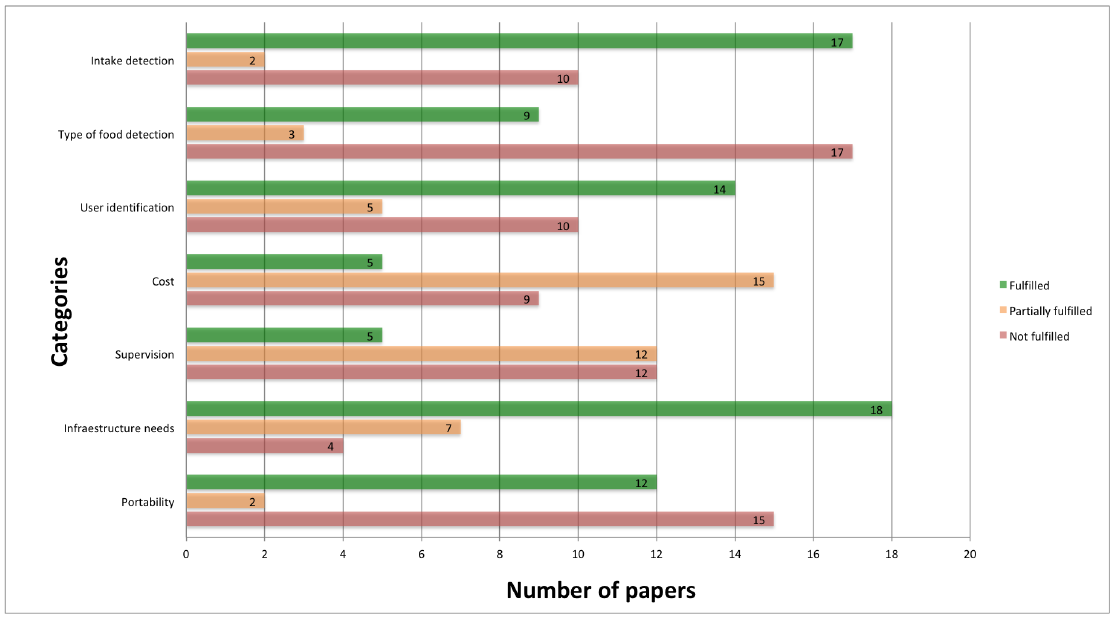
Figure 1. Number of papers in each